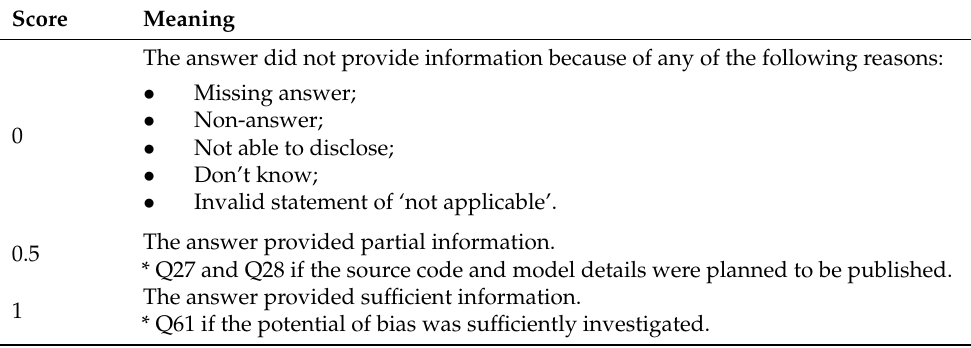
Table 1. Scale for scoring transparency and trustworthiness and applied to each question in the questionnaire. Each question was scored with either 0, 0.5, or 1, indicating the degree of transparency of their respective response. The * marks an additional condition for scoring a specific